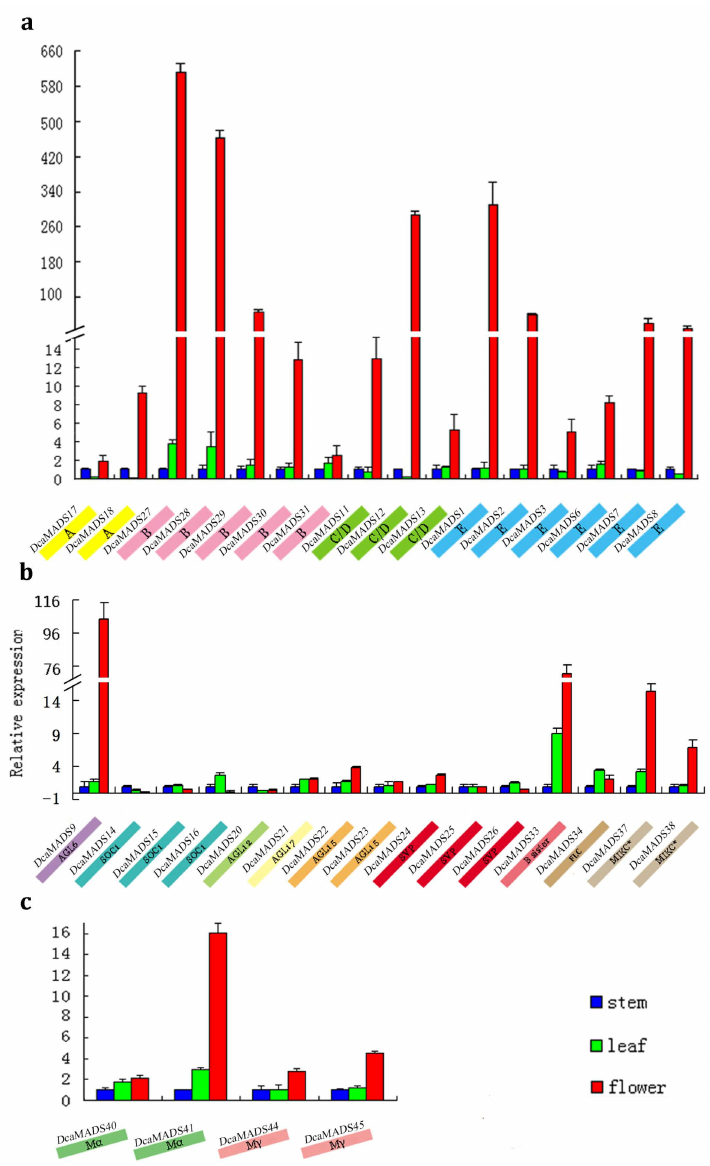
Figure 5. Expression analysis of 35 DcaMADS genes in different tissues, including stems, leaves, and flower buds. Each bar shows the standard deviation of triplicate assay. ( a ) The expression levels of 16 ABCDE DcaMADS genes which mean the class A, class B, class C/D and class E in the well-known ABC model of flowers. ( b ) The expression levels of genes in AGL6 (1), SOC1 (3), AGL12 (1), AGL17 (1), AGL15 (2), SVP (3), B sister (1), FLC (1), and MIKC * (2) subgroups. ( c ) The expression levels of four type I DcaMADS